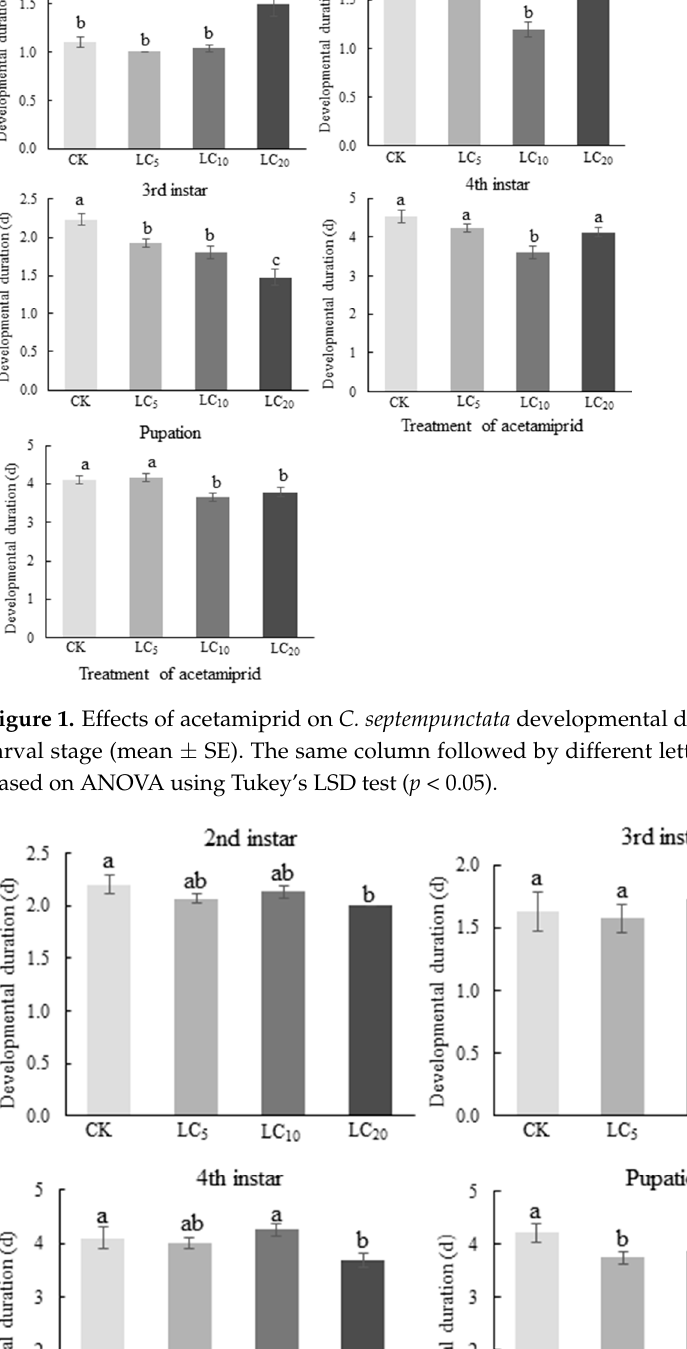
Figure 3. Effects of acetamiprid on developmental duration of C. septempunctata within the 3rd instar larval stage (mean ± SE). The same column followed by different letters is significantly different based on ANOVA using Tukey’s LSD test ( p < 0.05).